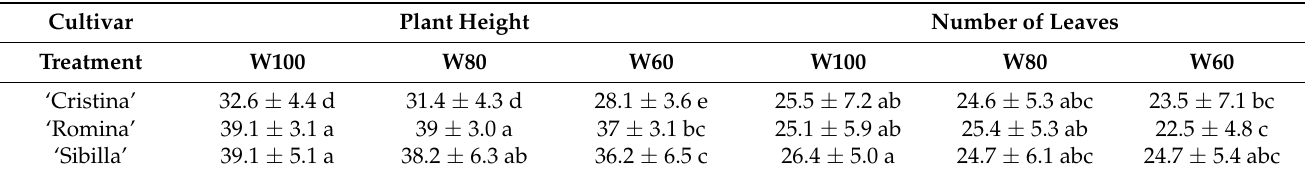
Table 6. Effects of water availability on plant height and leaf number in different strawberry cultivars. Values with the same lowercase letter for the same parameter were not statistically different for Fisher’s LSD test ( p < 0.05). Values are expressed as means of two years (2017–2018) ± standard deviation (SD).